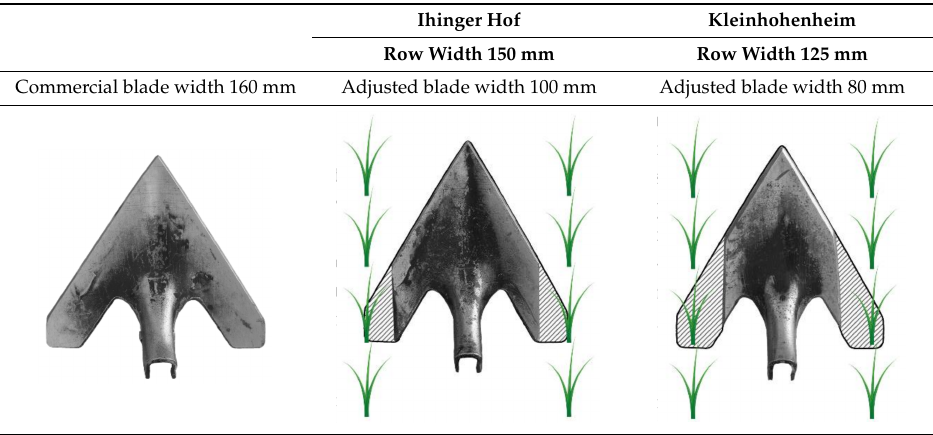
Table 1. Top view of the commercial and adjusted goosefoot sweeps with the narrow row widths of 150 and 125 mm at Ihinger Hof and Kleinhohenheim, respectively. Hatched lines symbolize the area cut off from the commercial 160 mm wide goosefoot sweep. The plants to the left and right of the sweeps symbolize cereal rows.